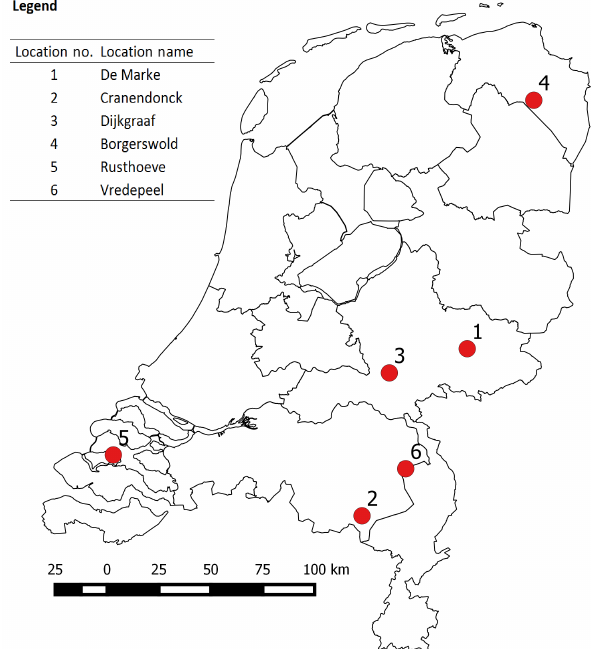
Figure 1. Location of the case studies for grassland, maize and pota- toes; location De Marke has a rotation of grassland and maize on the same